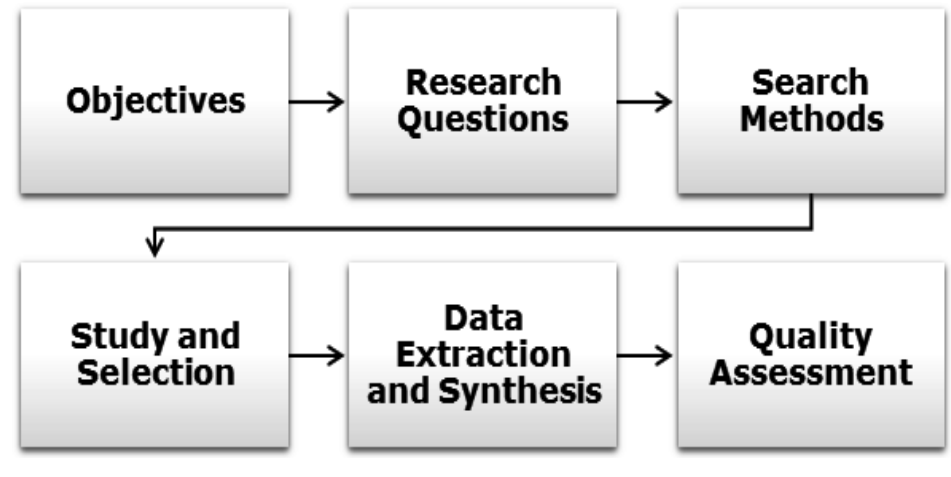
Figure 1. Steps of the literature review methodology.